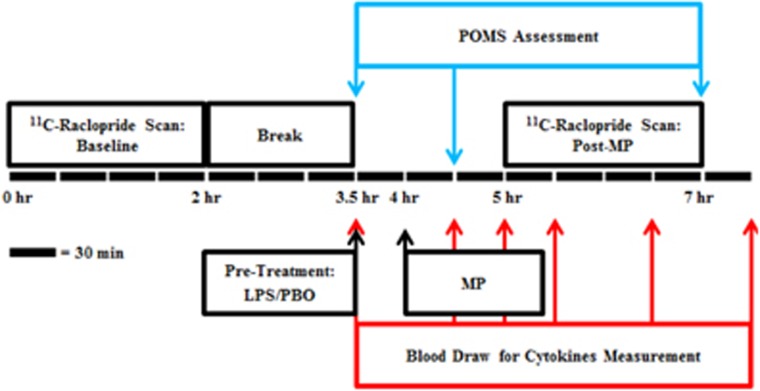
Schematic depiction of a session containing two 11C-raclopride PET scans: baseline and post MP. Each subject underwent two of these sessions with different pre-treatments: LPS or placebo. The order of the sessions was randomized. Blood sampling and POMS questions were performed periodically (denoted by arrows) from the start of pre-treatment until the end of the post-MP scan. LPS, lipopolysaccharide; MP, methylphenidate; PET, positron emission tomography; PBO, placebo; POMS, Profile of Mood States.